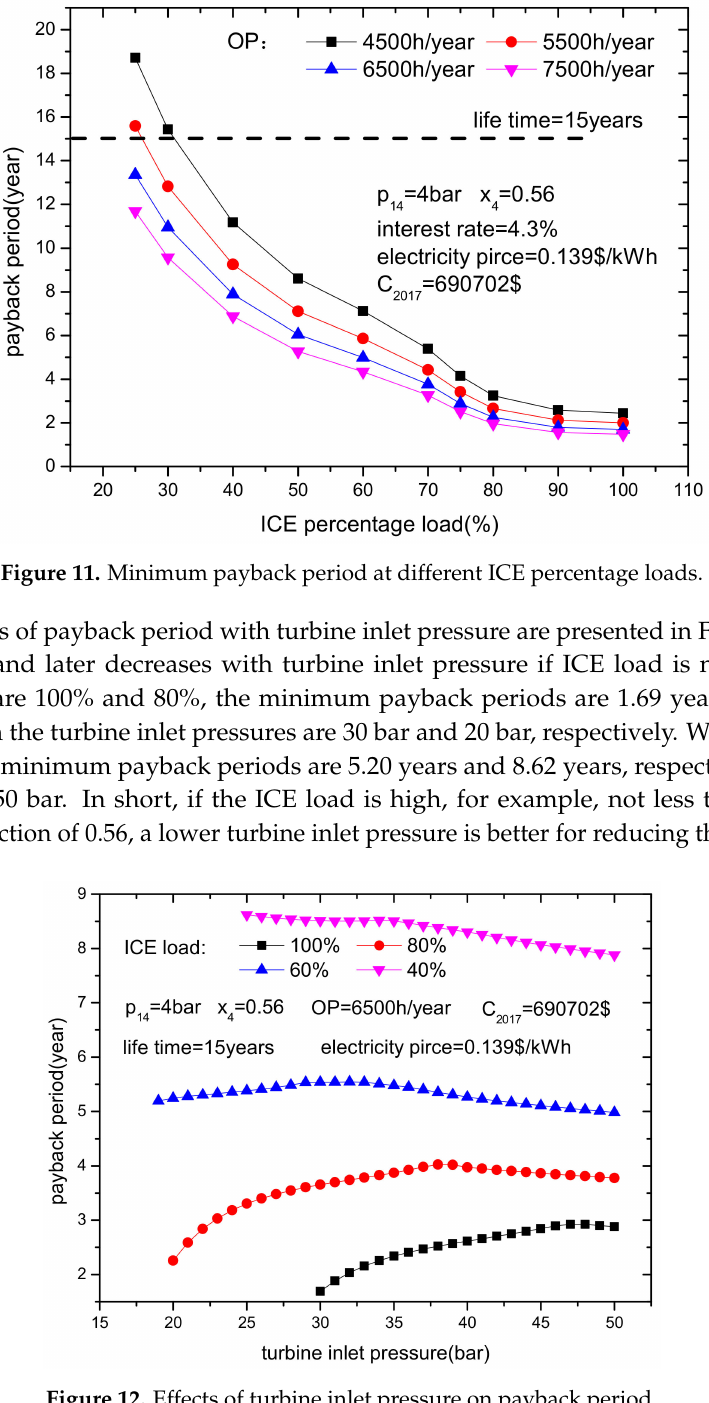
Figure 12. Effects of turbine inlet pressure on payback